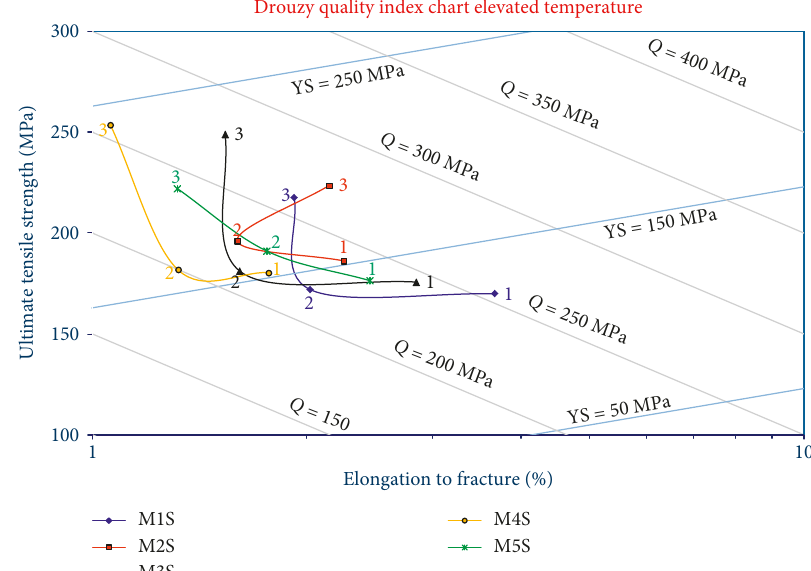
Figure 6: Drouzy quality chart representing the relation between the UTS and the percent elongation to fracture values of the alloys studied in the as-cast and T5- and T6-treated conditions obtained at 250 ° C.